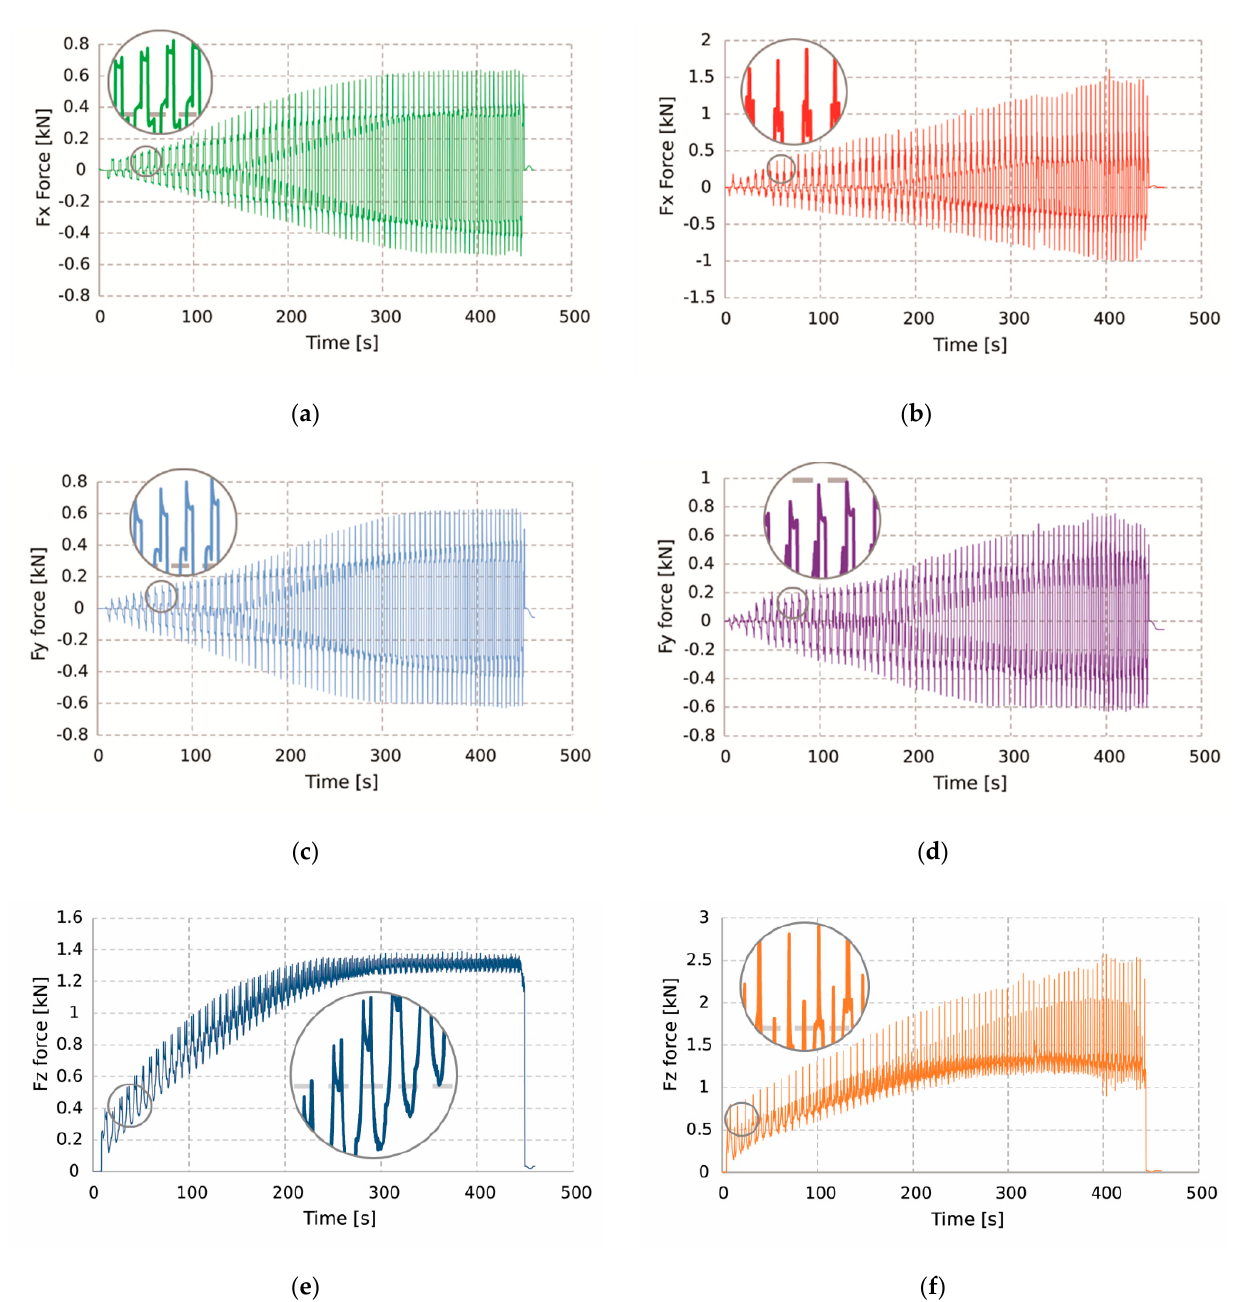
Figure 10. The Fx force variation for unwelded blanks ( a ) and double side welded blanks ( b ), the Fy force variation for unwelded blanks ( c ) and double side welded blanks ( d ) and Fz force variation for unwelded blanks ( e ) and double side welded blanks ( f ) for truncated pyramid-shaped parts. Table 7. Results for unwelded blanks processed by SPIF in truncated cone shape.